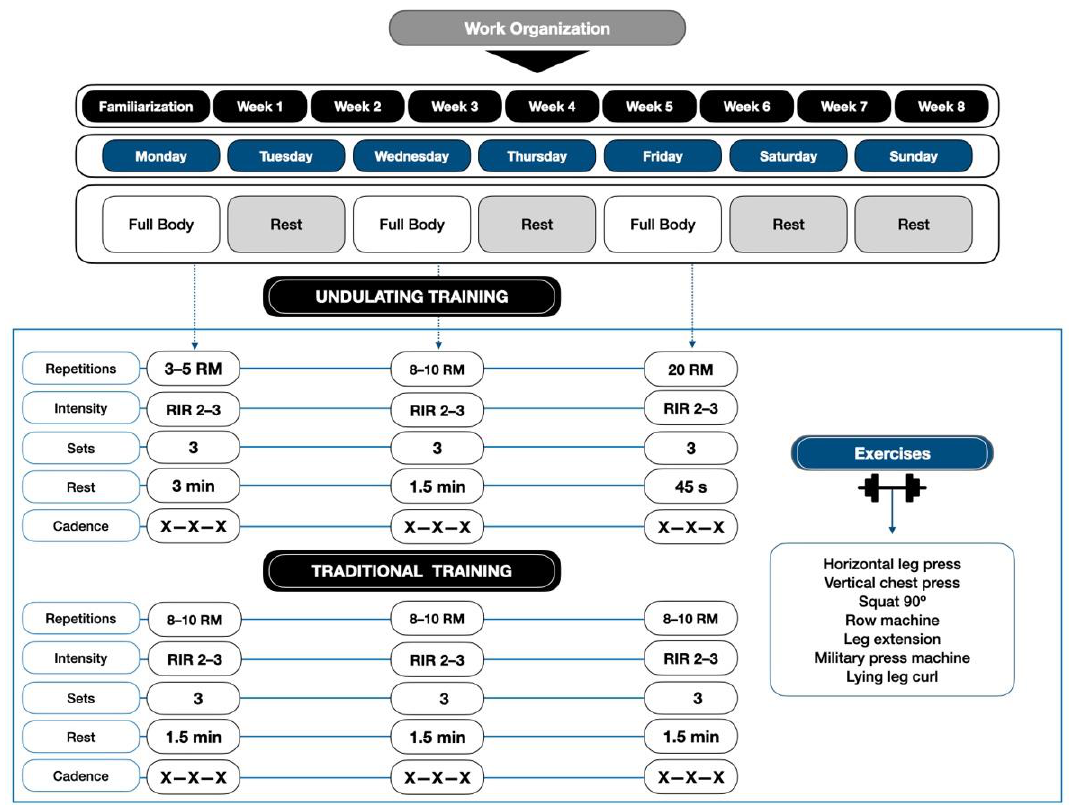
Figure 1. Resistance Training Organization. X-X-X = maximal intended velocity in the concentric, eccentric, and isometric phases; RIR = repetitions in reserve.